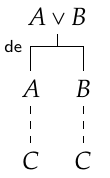
Figure 3. ∨ -Elimination as a multiple-conclusion